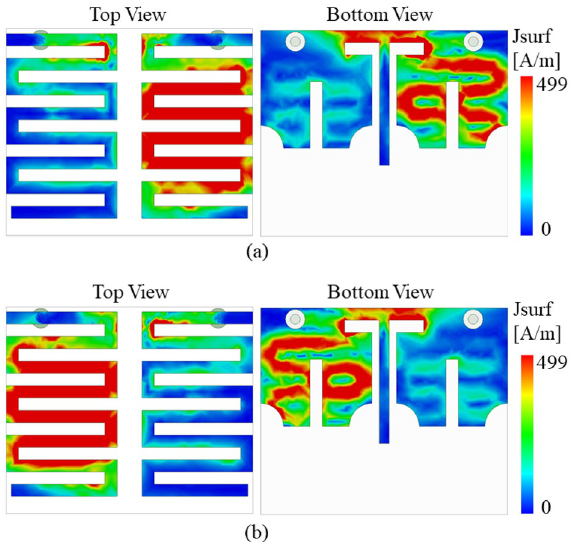
Figure 10. J surf at 2.45 GHz when ( a ) port 1 of the antenna is excited, and ( b ) port 2 of the antenna is